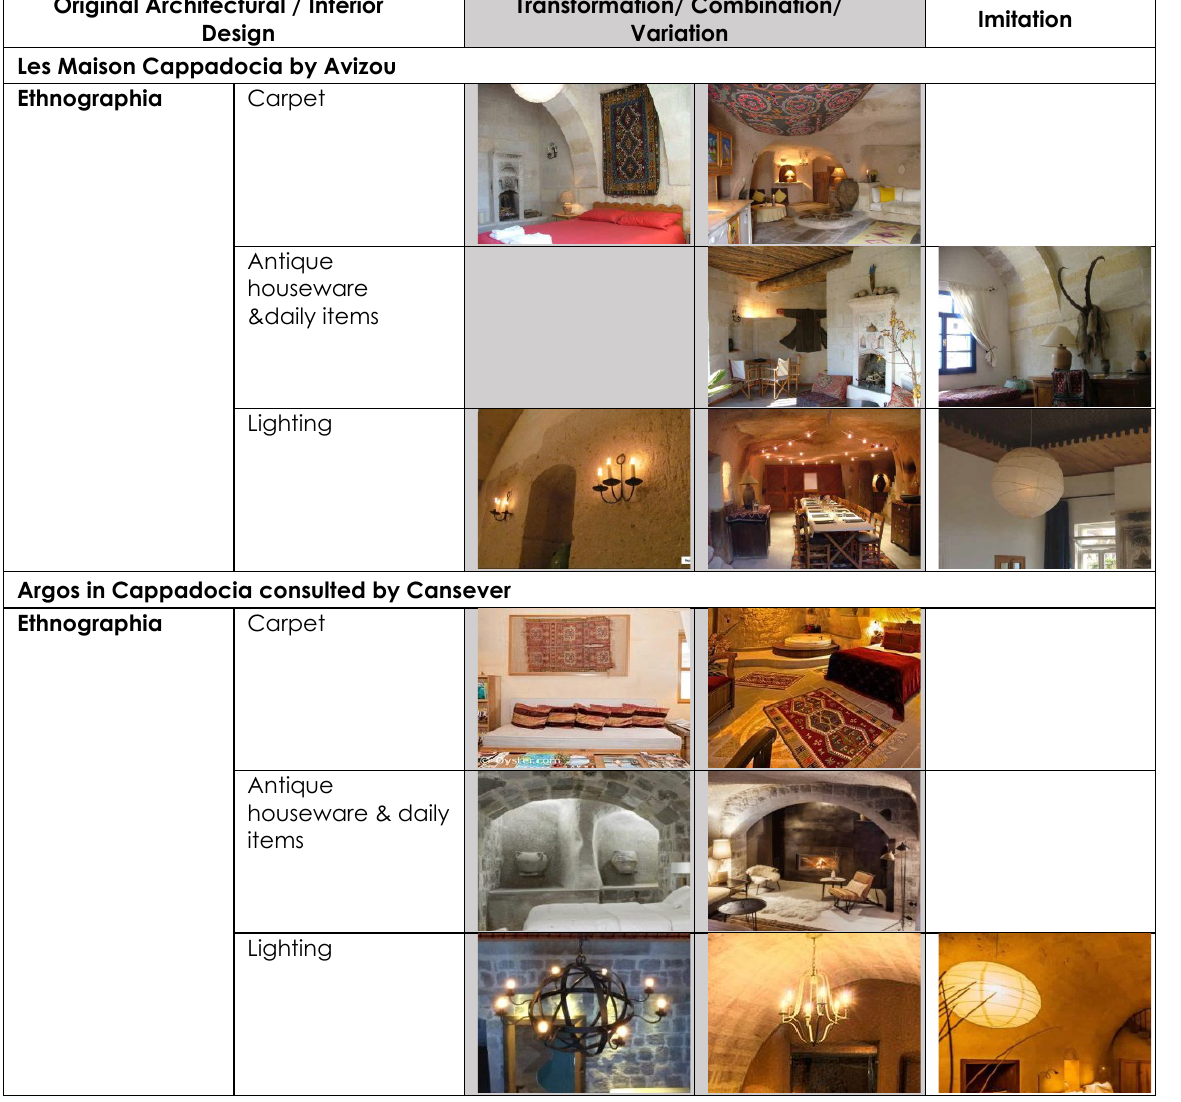
Table 9. Taxonomy of Design Guideline ‘Et h nographia’ according to Levels of Novelty. (Les Masion Cappadocia., 2019), (Argos Yapi 2019)) Original Architectural /